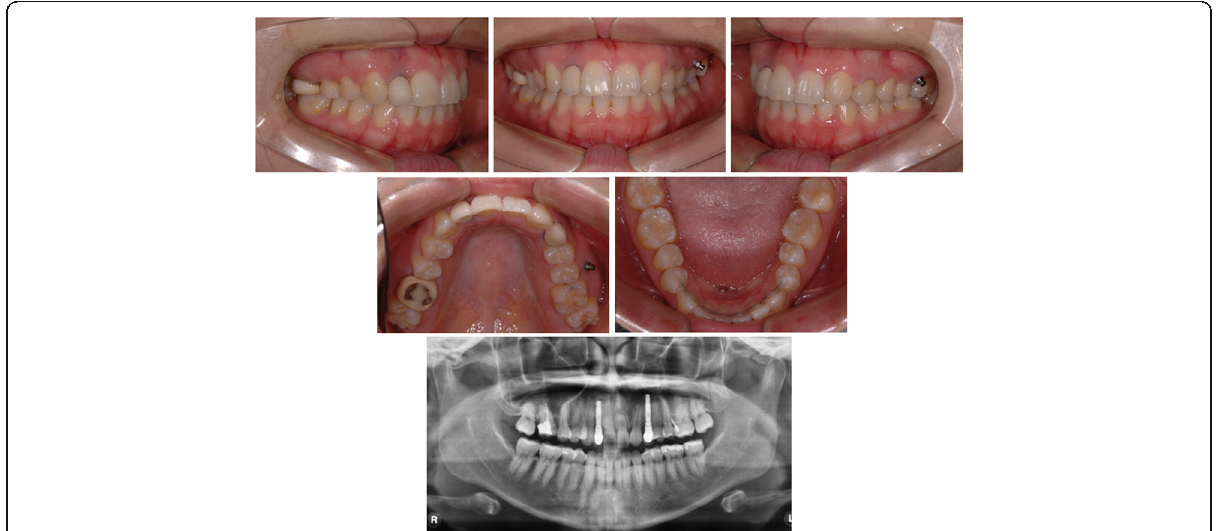
Fig. 5 Post-treatment intraoral photographs and panoramic radiograph after implant